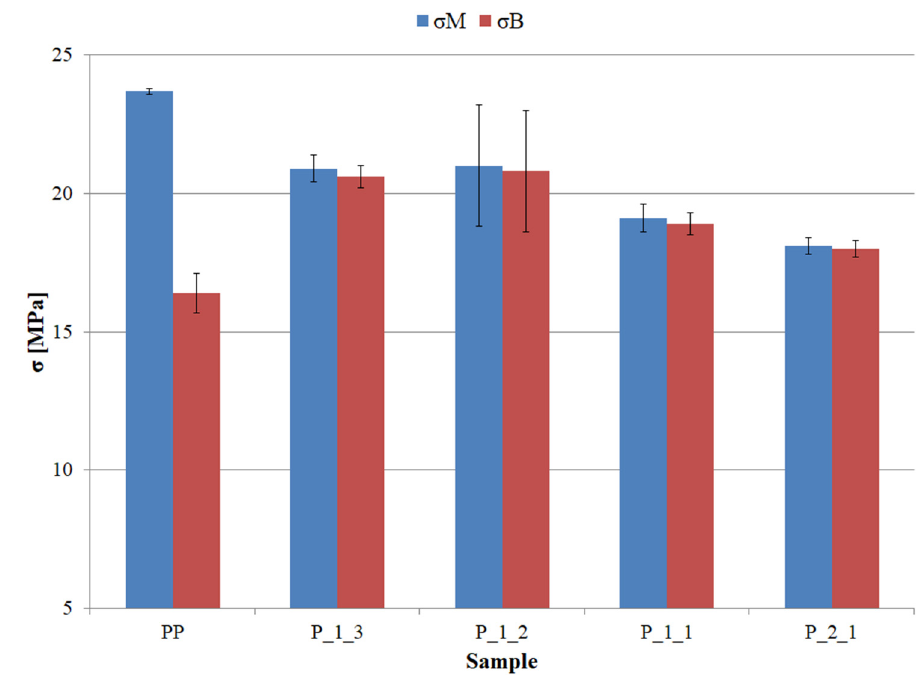
Figure 4. Tensile strength ( σ M ) and stress at break ( σ B ) of individual samples.